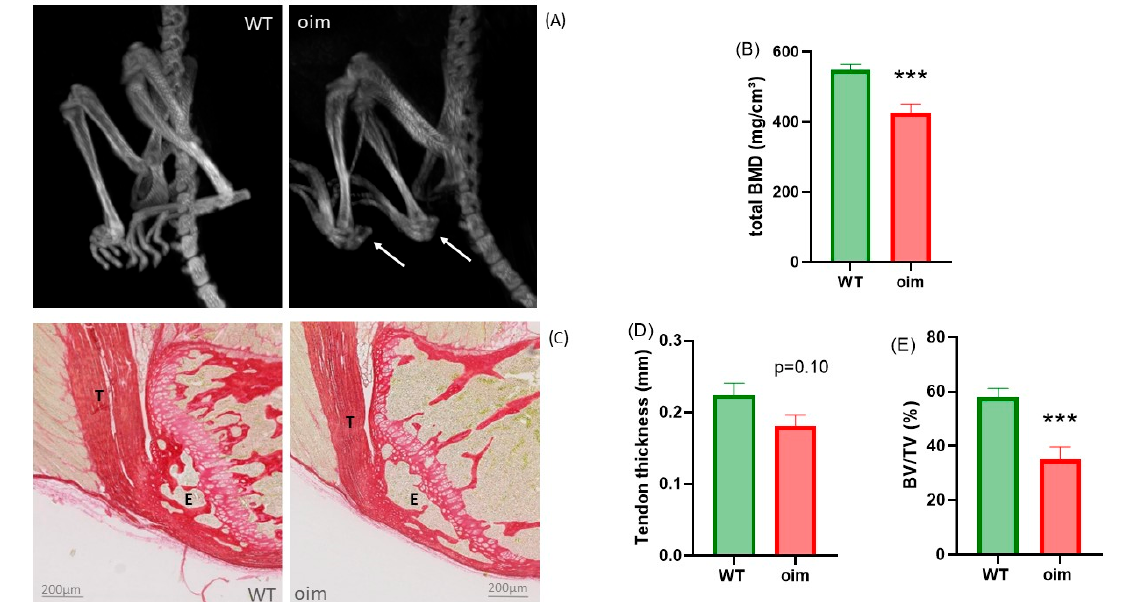
Figure 1. ( A ) Lower limb imaging with in vivo CT of WT and oim mice. Both oim calcanei show avulsion fractures (arrow). ( B ) pQCT total bone mineral density (BMD, mg/cm 3 ) in ulna epiphysis. ( C ) Sagittal section through ulna epiphysis with insertion of triceps brachii tendon on the olecranon of the ulna in WT and oim mice; Sirius Red staining, T = tendon and E = epiphysis of olecranon (ulna). ( D ) Tendon thickness (mm) of triceps brachii tendon. ( E ) Bone volume/total volume (BV/TV, %) ratio in ulna epiphysis, *** p < 0.001.